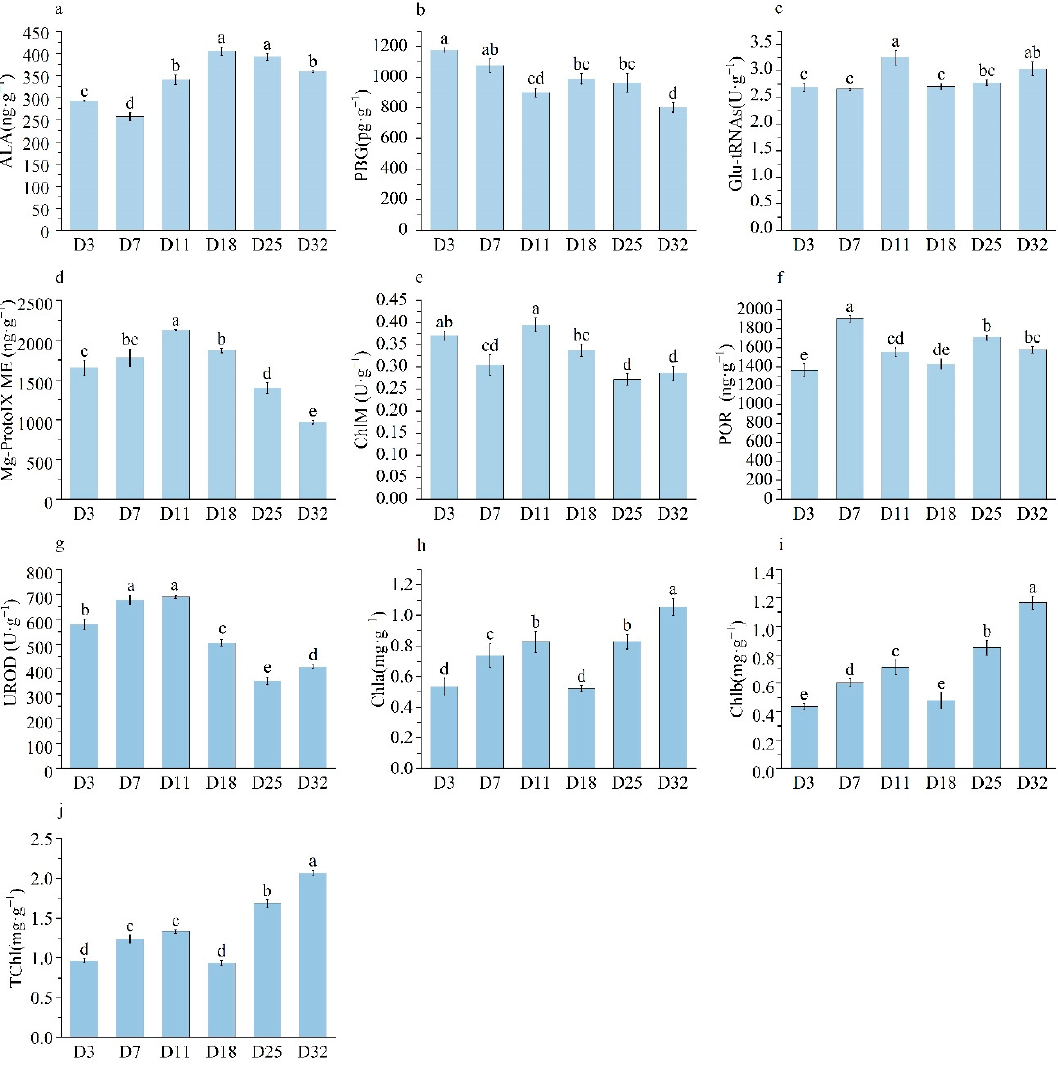
Figure 7. Chlorophyll precursor and chlorophyll content of different sampling time.